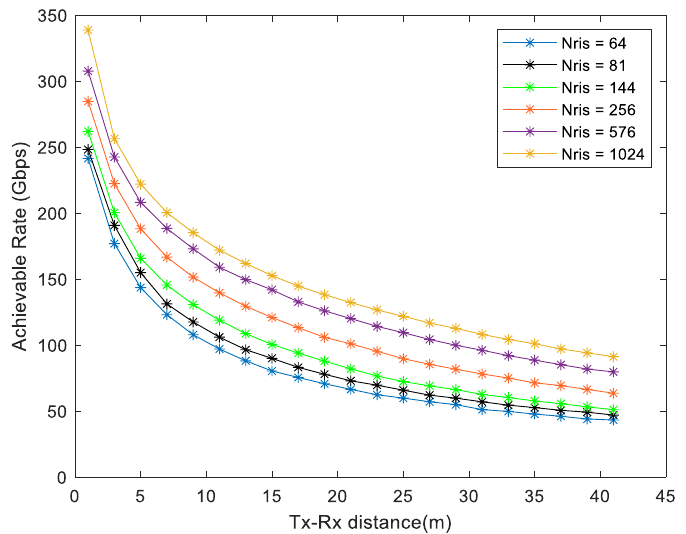
Figure 4. Achievable rate of the proposed APG for various elements in RIS versus distance between BS – User.